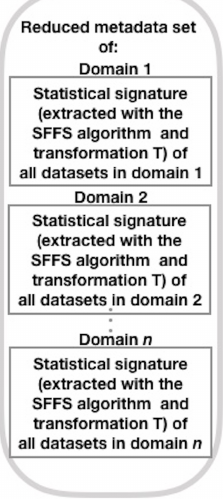
Figure 4. Generalization step (adapted from Brena et al. [12]).